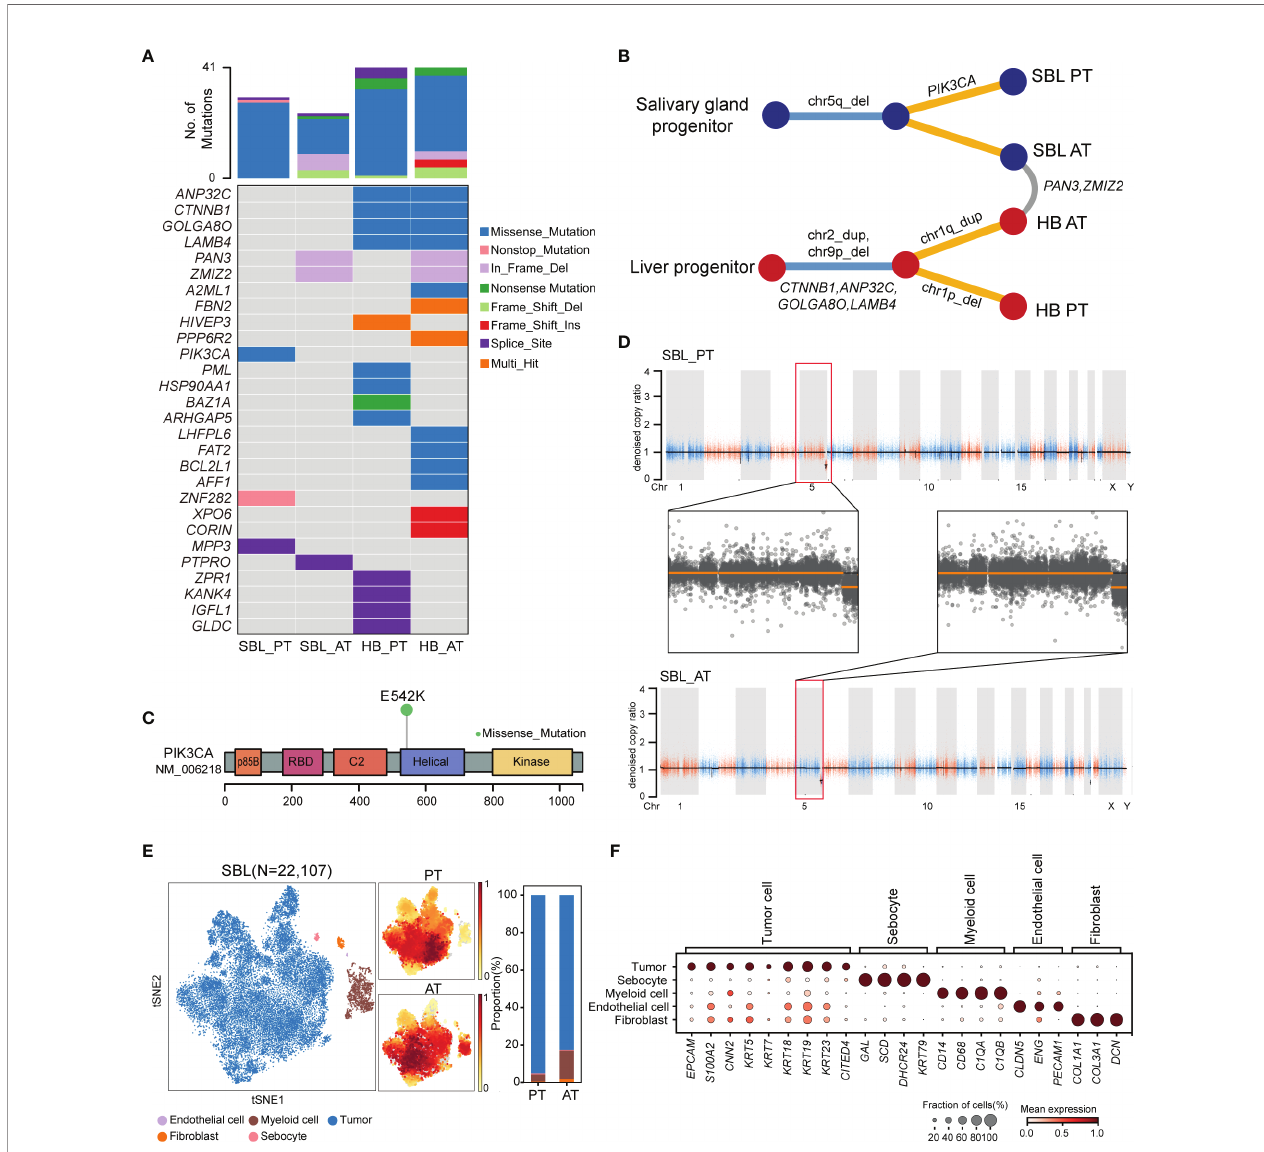
FIGURE 2 | The genomic and transcriptomic landscape of SBL. (A) Oncoplot outlining the distribution of mutations across 4 tumor samples. The color indicated different variant types. (B) Phylogenetic tree diagram showing key somatic mutations as well as shared mutated genes and copy number alterations. (C) Lollipop plot showing the hot spot mutation of PI3KCA p.E542K. Boxes represent functional domains. p85B, p85 binding domain; RBD, Ras binding domain. (D) Scatter plots showing copy number alterations in SBL PT and AT samples. (E) tSNE visualization of 22,107 cells from SBL colored by cell types (left) and density of sample distribution(middle). The right panel shows the proportions of different cell types in SBL PT and AT samples. tSNE, t-distributed stochastic neighbor embedding. (F) Dot plot for expression of cell-type-speci fi c markers in SBL. The color indicated the scaled mean expression of marker genes, and the size indicated the proportion of cells expressing marker genes. SBL, sialoblastoma; HB, hepatoblastoma; PT, primary tumor; AT, tumor after